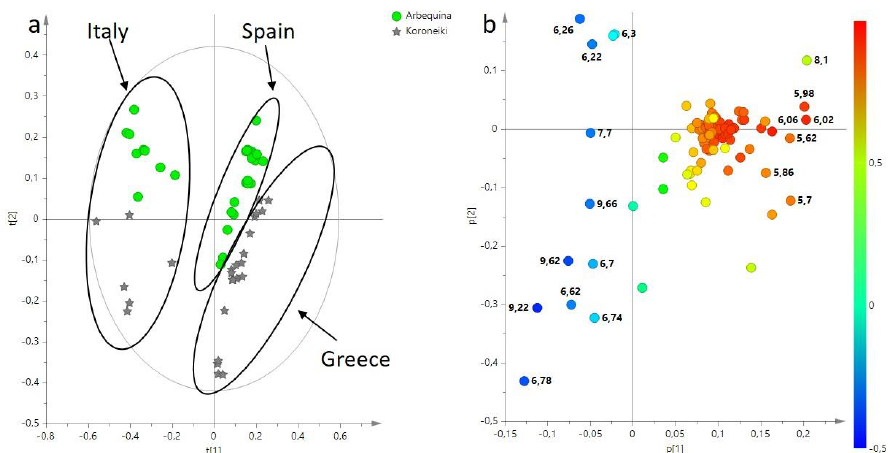
Figure 4. ( a ) t[1]/t[2] PCA score plot performed on minor components (BUCKET-2) of Arbequina and Koroneiki EVOOs samples obtained from Spain, Greece, and Italy, ( b ) PCA loading plot, colored according to the correlation-scaled loading (p(corr) vector). The variables indicated the chemical shift value (ppm) in the 1 H NMR spectrum.